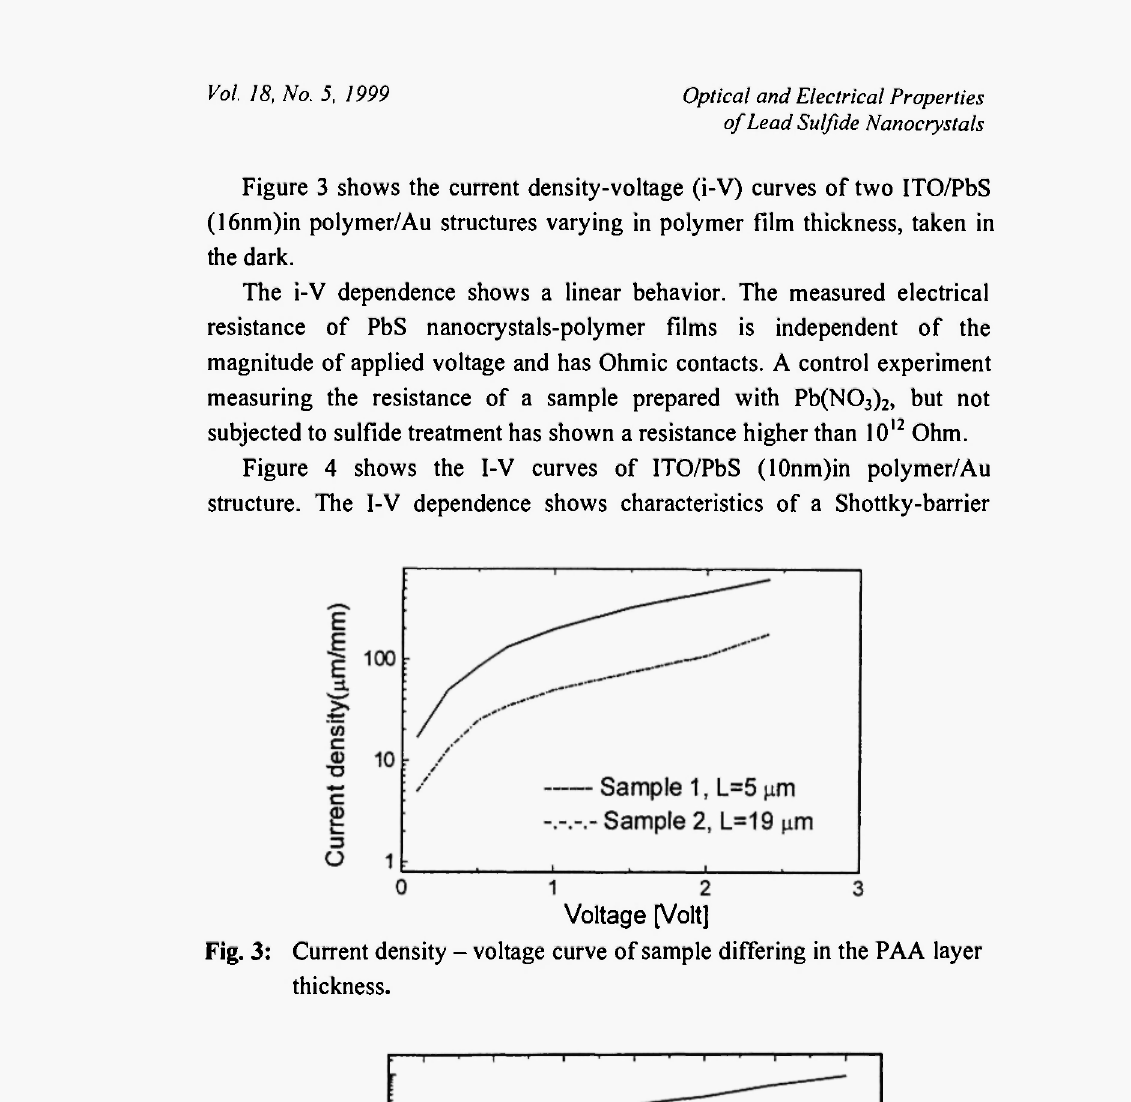
Fig. 3: Current density - voltage curve of sample differing in the PAA layer